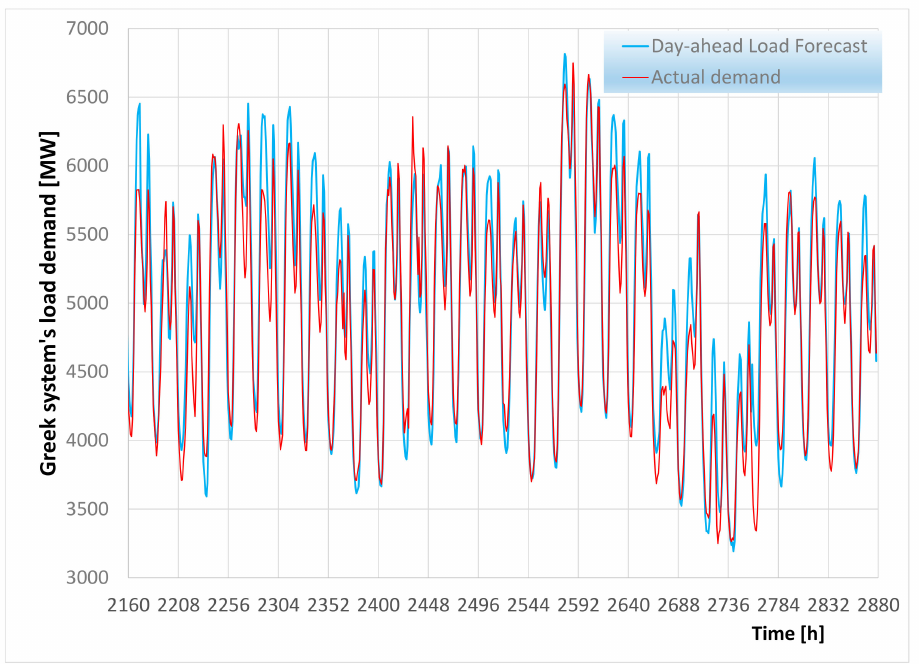
Figure 4. Greek system load during April 2022, day-ahead predicted versus actual values (MW) [35].